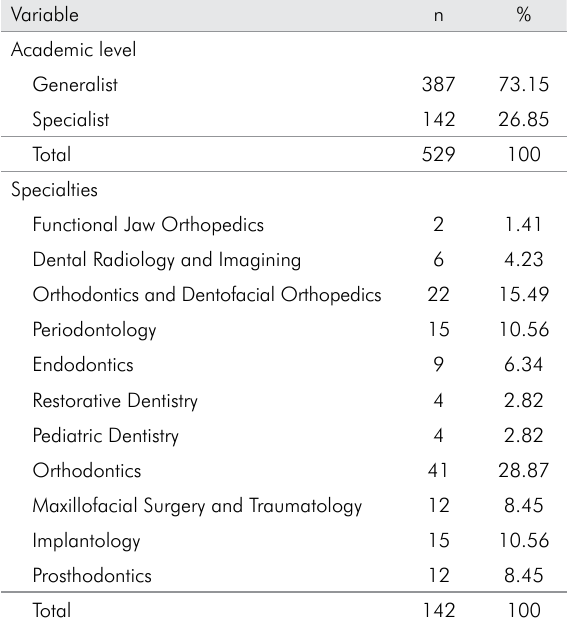
Table. Percent distribution of lawsuits analyzed at the CRO/ ES between 2000 and 2010, according to the dentists’ spe- cialty. Source: CRO-ES, Vitória, 2011.